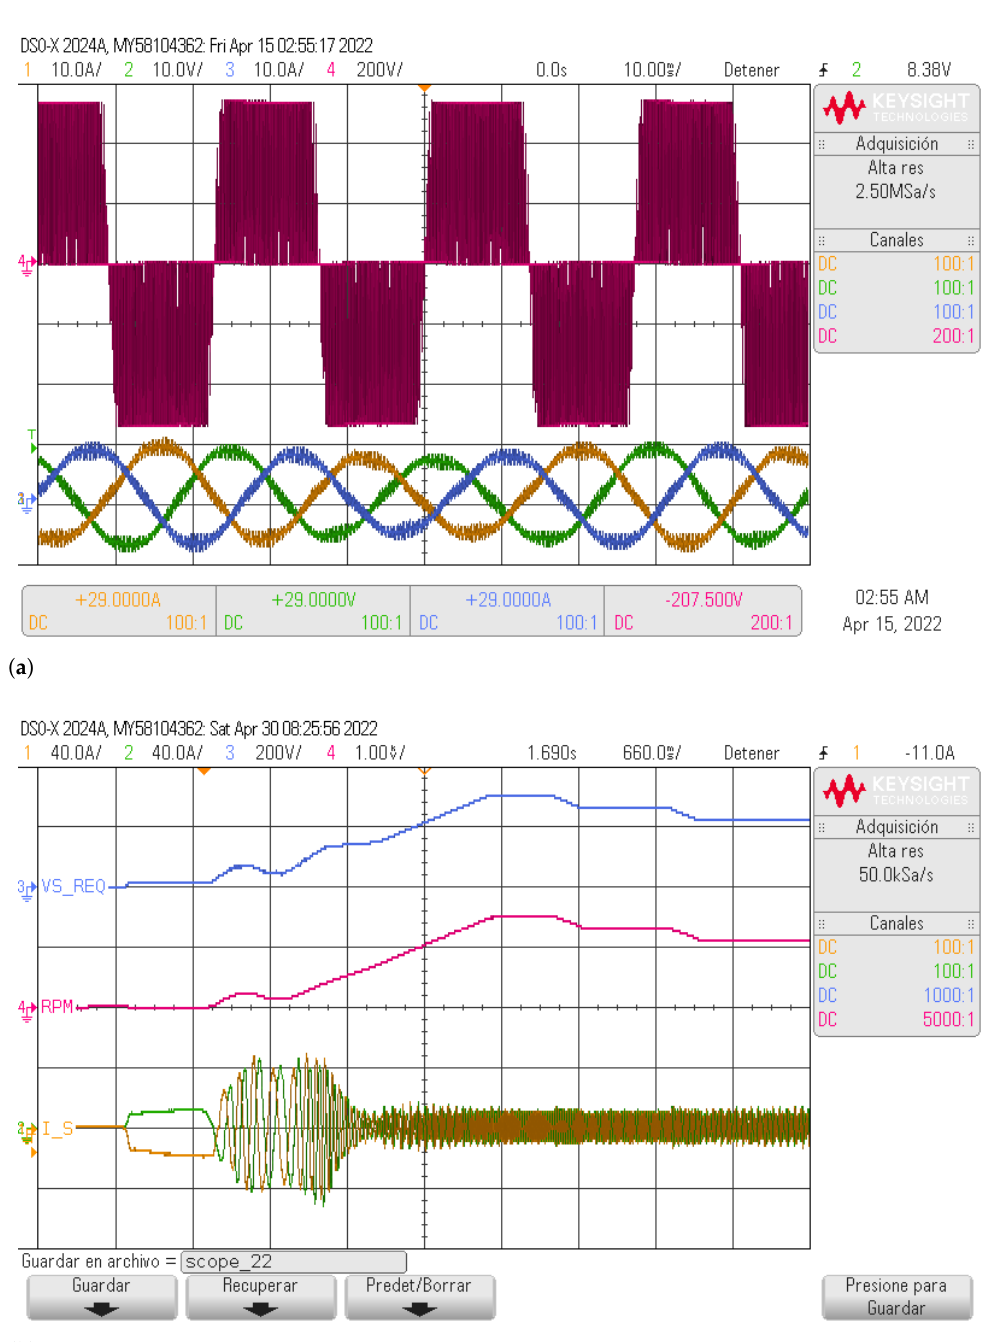
Figure 8. Proposed HST-SCS experimental results. ( a ) Oscilloscope waveform of a-b line voltage and phase currents, during 100 ms around 4.2 s. ( b ) Oscilloscope waveforms of V ∗ s , ω r , and phase currents i a and i b